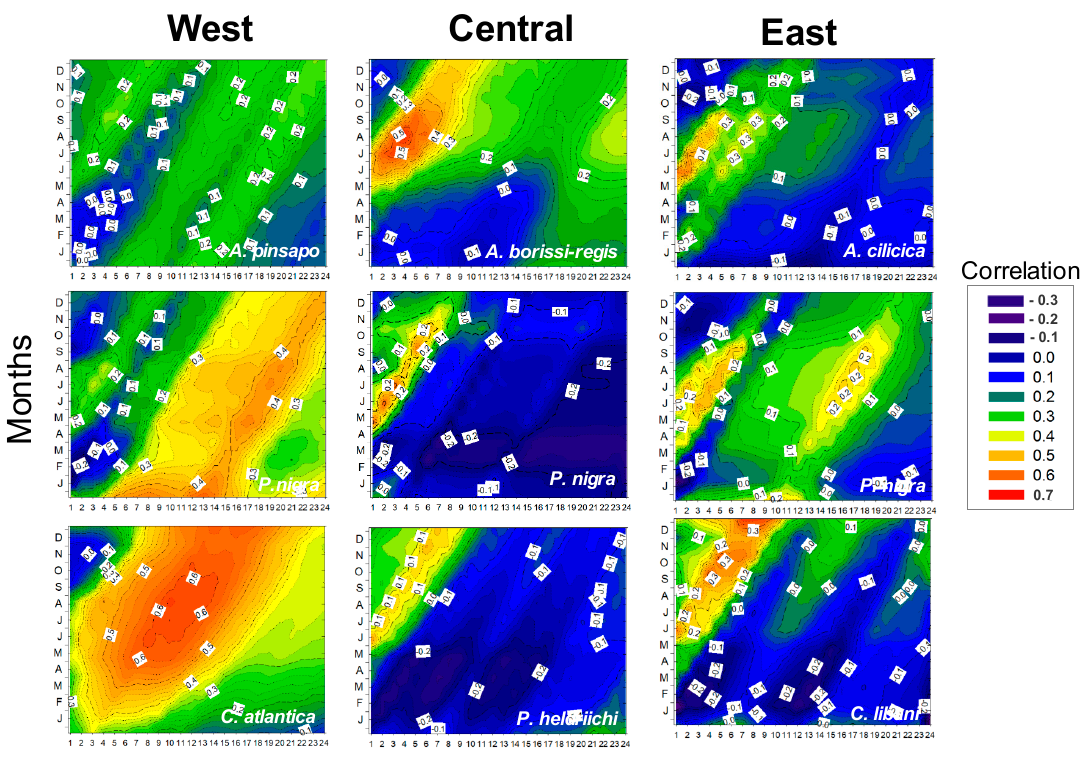
Figure 4. Drought–growth associations of the studied sites in the Mediterranean Basin (from the left to the right for respective rows) assessed by relating ring-width indices (TRWi) to the Standardized Precipitation–Evapotranspiration Index (SPEI) considering for up to 24-month-long scales ( x axes). Correlations were calculated for the common and best-replicated period of 1946–2010 and considering the months of the current growth year ( y axes). Correlation values above + 0.25 and below − 0.25 were significant at the p < 0.05 level. Sites’ codes are as in Table 1. Table 4. Mann–Kendall statistic and related probability levels assessing NAO, WI, and site SPEI (3 months) trends for selected months during the period 1946–2010 and considering the nine Mediterranean study sites, p < 0.05 (italic values) and p < 0.01 (bold values). SPEI 3 West Central East Month NAO